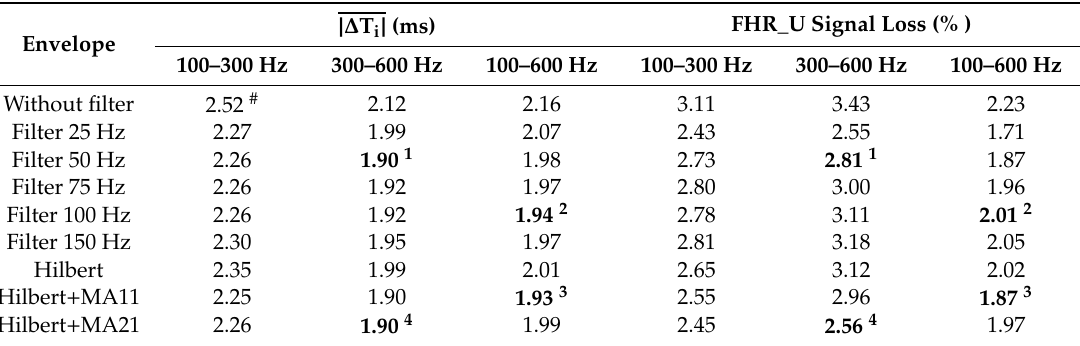
Table 1. Interval-measurement errors and FHR_U signal loss obtained for three US signal bandwidths and nine envelope determination methods when using a classical AF calculated every 250 ms for a window width of 1.5